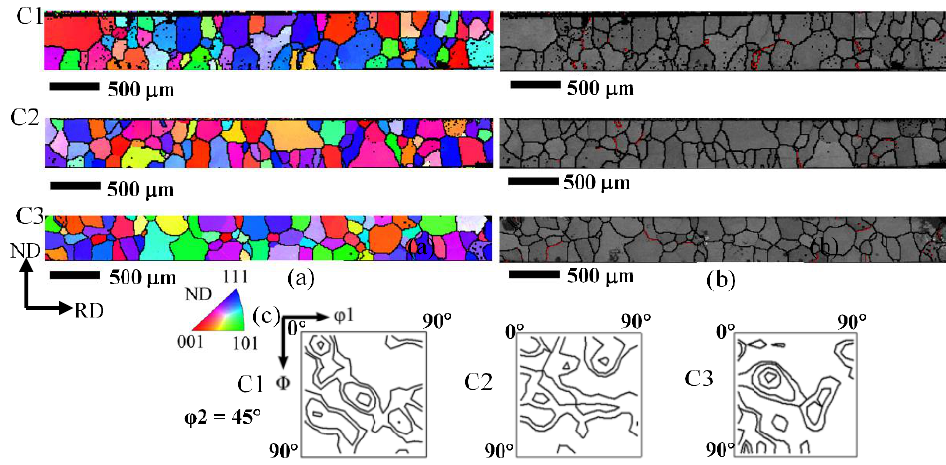
Figure 13. EBSD maps of 2# sheets after final transformation treatment under three conditions C1 to C3 of cold rolled 0.5 mm sheets from initial hot-rolled structure. ( a ) IPF-ND maps; ( b ) band contrast maps (red lines: Σ3); ( c ) ODFs at ϕ 2 = 45° section.